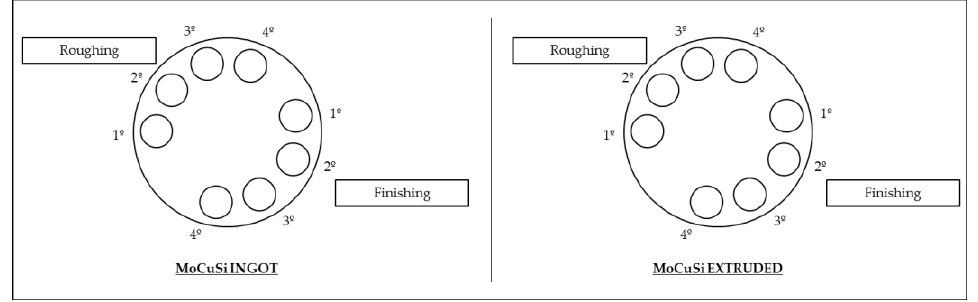
Figure 3. Scheme of electrical discharge machining (EDM) operations for both materials ordered by hole number.